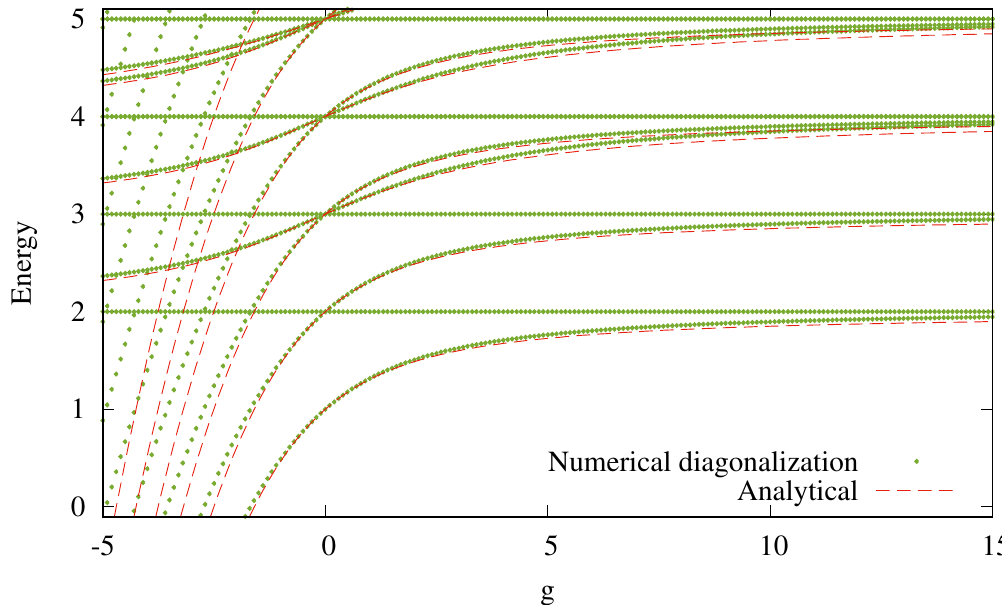
Figure 1. Energy spectrum of the two-particle system as a function of the interaction strength. The calculations are performed using 100 single-particle modes (green dots). The analytical spectrum (dashed red line) is obtained with Equation (43) for the energy of the relative system and adding after the possible energies of the center of mass. Energy given in harmonic oscillator units. The energies obtained via Equation (43) correspond to even-parity states, the corresponding odd-parity states do not depend on the interaction, and result in horizontal lines in close agreement with the numerical